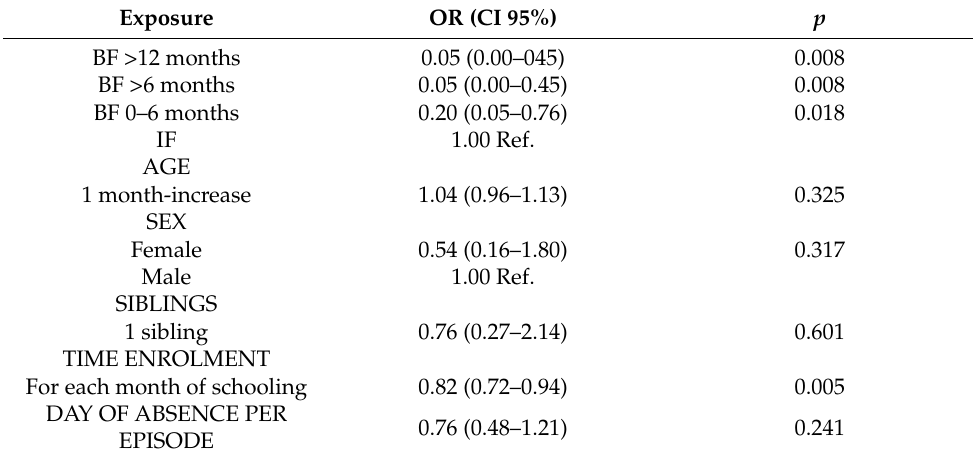
Table 4. Multivariate analysis. Dependence behaviors at the time of pick up from the center